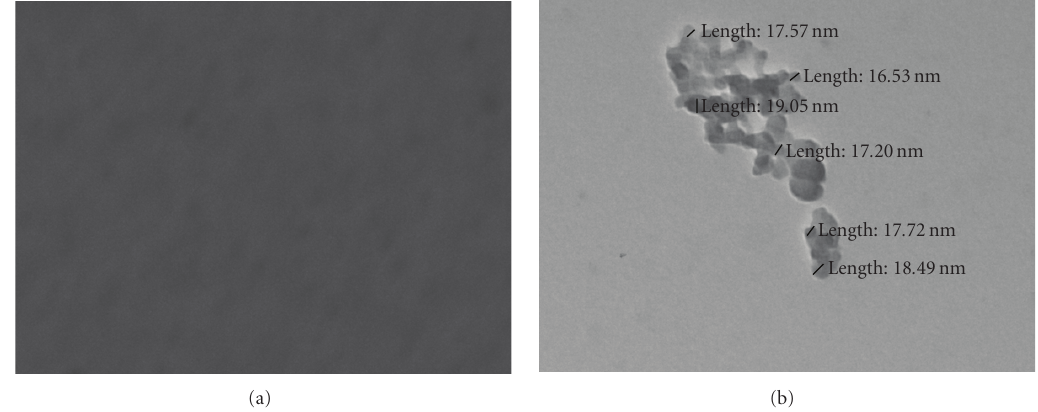
Figure 3: TEM images of (a) Acrylate matrix (without metal dispersion) (b) Acrylate matrix (with metal dispersion). The images confirm the dispersion of particles of size < 20 nm.